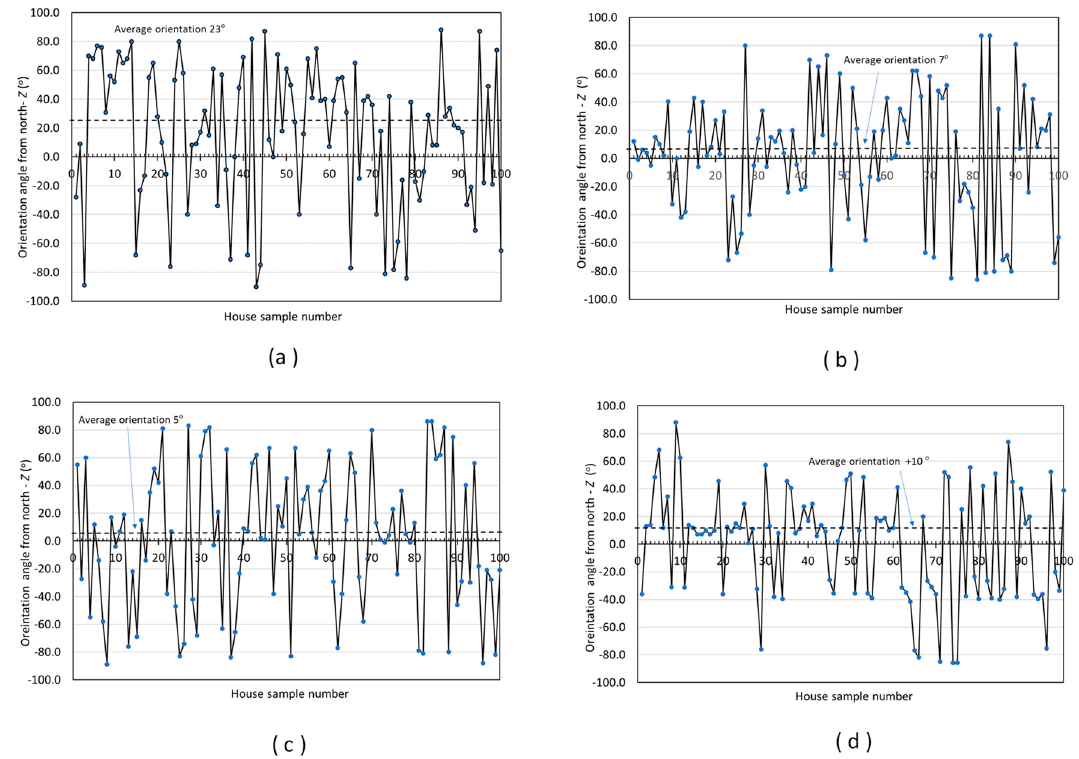
Figure 7. Roof orientation angle ( Z ) in four suburbs: ( a ) Newtown, ( b ) Redfern, ( c ) Erskineville, ( d ) Rosebery. Y axis values represent roof orientation: Zero is toward north, 90° is toward East, − 90° is toward west.